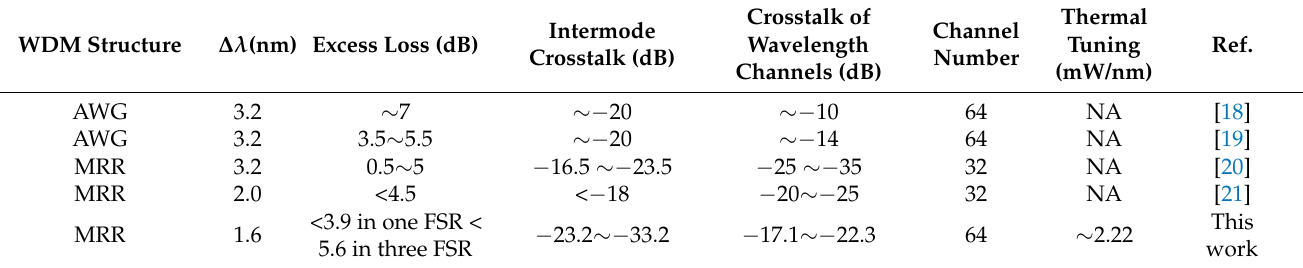
Table 1. Comparison of hybrid WDM–MDM